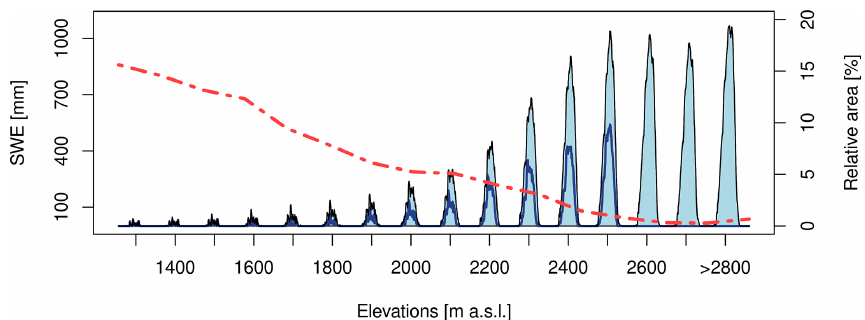
Figure 10. Mean annual evolution of SWE at different elevation bands. The dark blue line represents the Anti-Lebanon Mountains, the black line the Mount Lebanon range and the red line the relative areal coverage of each elevation above 1300ma.s.l.